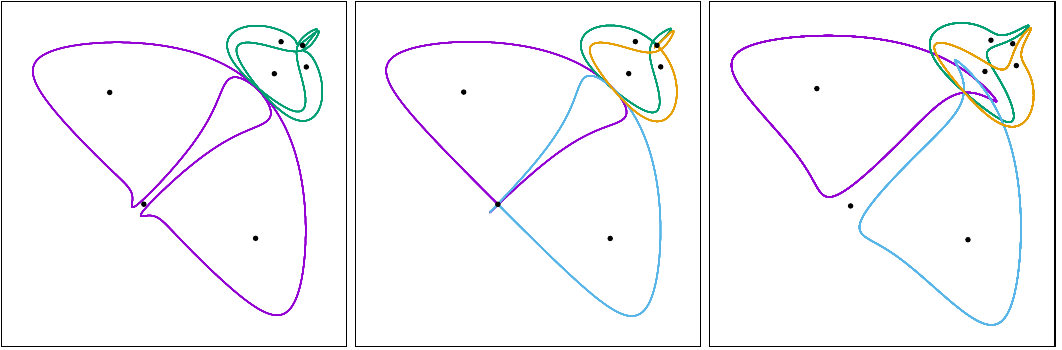
Figure 6. Similar to Figure 5, but now the collision of periodic orbits with an equilibrium increases the number of coexisting attractors; the equilibria are marked by a bullet. All panels represent the square [ − 0.4,1 ] × [ − 0.4,1 ] in the ( x 0 , x 2 ) -plane. The used parameter values are: F = 0.707264 ( left ), F = 0.708032 ( middle ), and F = 0.716384 ( right ).